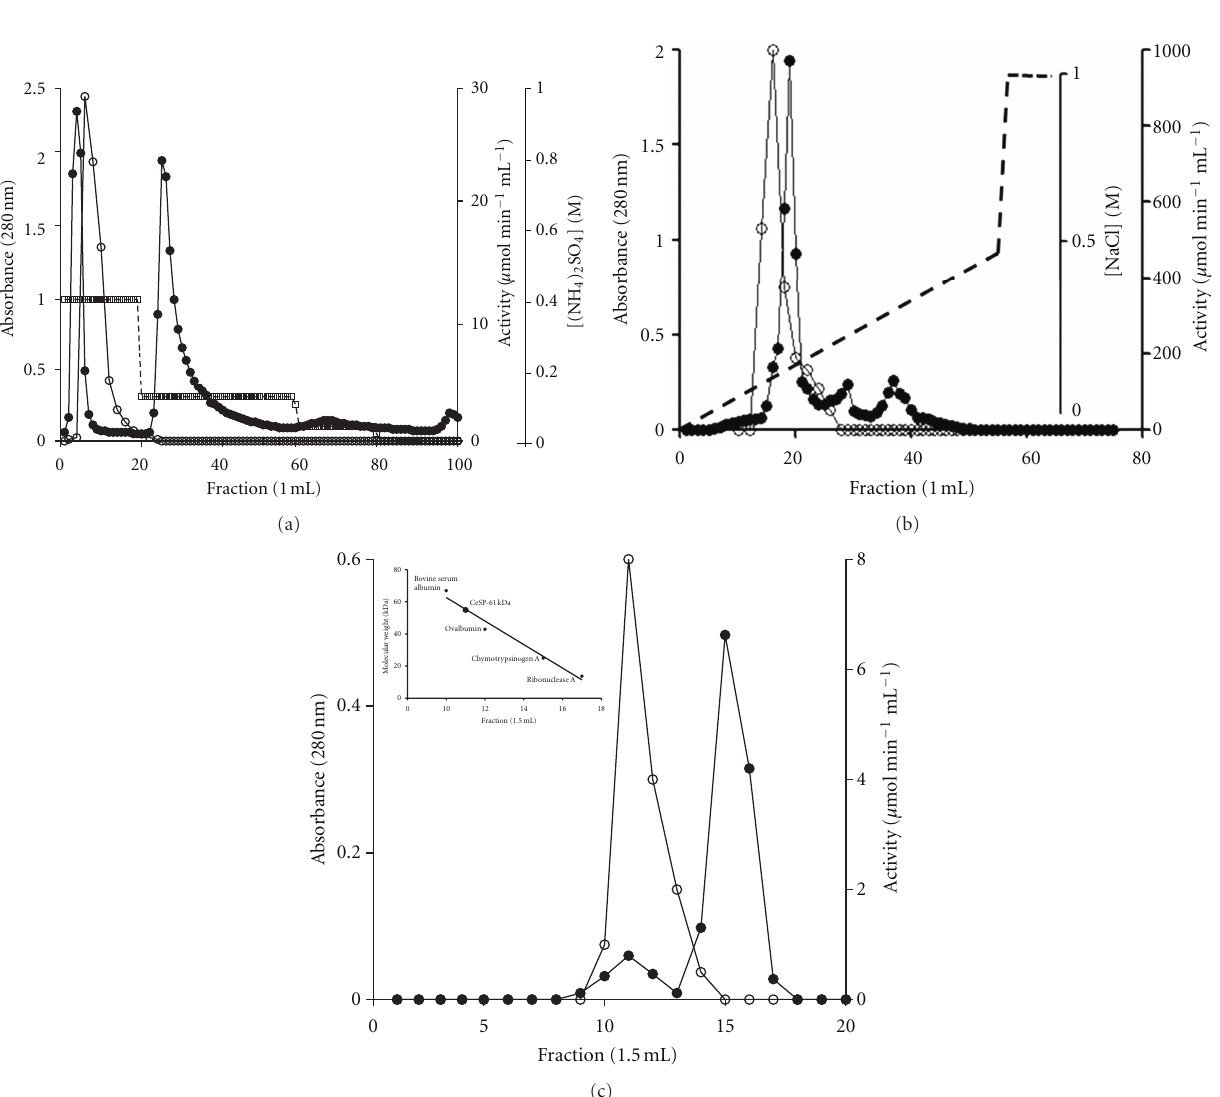
Figure 1: Elution profile of CeSP purification. (a) Hydrophobic interaction chromatography, where a Hitrap Phenyl column was equilibrated with 50mM phosphate bu ff er, pH 7.0, 1.0M (NH 4 ) 2 SO 4 , and proteins were eluted with (NH 4 ) 2 SO 4 (0.95, 0.25, and 0.13 M). (b) Anion exchange chromatography, where a Resource Q column was equilibrated with 50mM Tris bu ff er, pH 7.5, and proteins were eluted with a linear NaCl (0 to 0.50 M) gradient. (c) Gel filtration, where a Superdex 75 column was equilibrated with 50 mM phosphate bu ff er, pH 7.0, 0.15 M NaCl, and proteins were eluted in the same bu ff er. Inset: molecular masses as function of protein elution. Standard proteins: BSA (67.0 kDa), ovalbumin (43.0kDa), chymotrypsinogen A (25.0kDa) and ribonuclease A (13.7 kDa). All fractions were monitored by the absorbance at 280 nm ( • ) and enzymatic activity ( ◦ ).